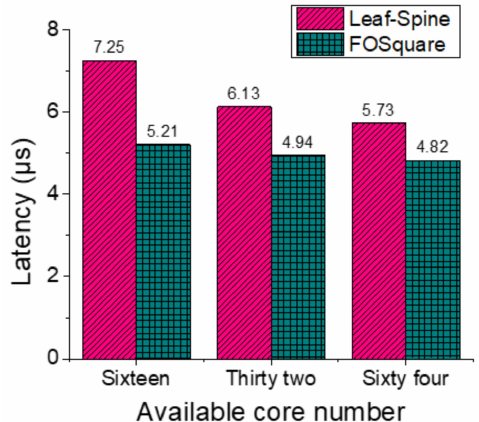
Figure 6. CG application Latency.